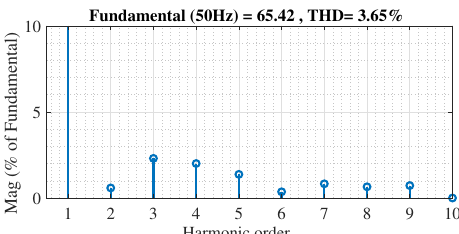
Figure 23. Harmonic spectrum of output voltage.